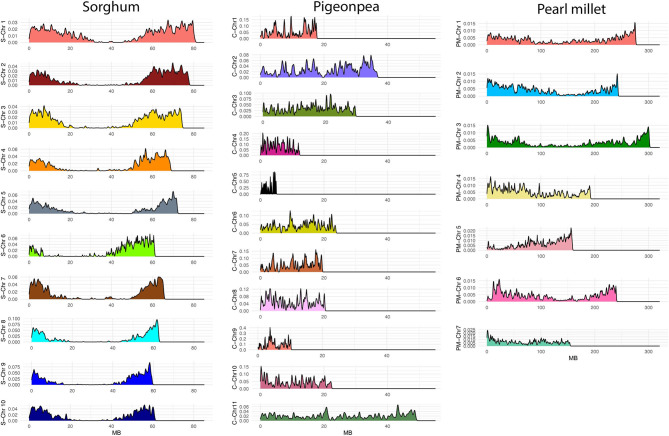
SNP densities over chromosomes of sorghum (S-Chr 1–10, the letter “S” represents sorghum), pigeonpea (C-Chr 1–11, the letter “C” represents Cajanus), and pearl millet (PM-Chr 1–7, the letter “PM” represents pearl millet) after filtering for quality parameters. The x-axis represents SNP positions along each chromosome (MB) and the y-axis represents SNP densities over chromosomes.